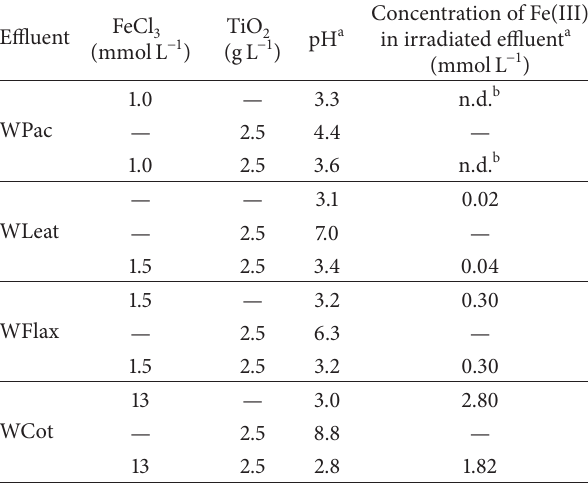
Table 2: The concentrations of reagents used and experimental